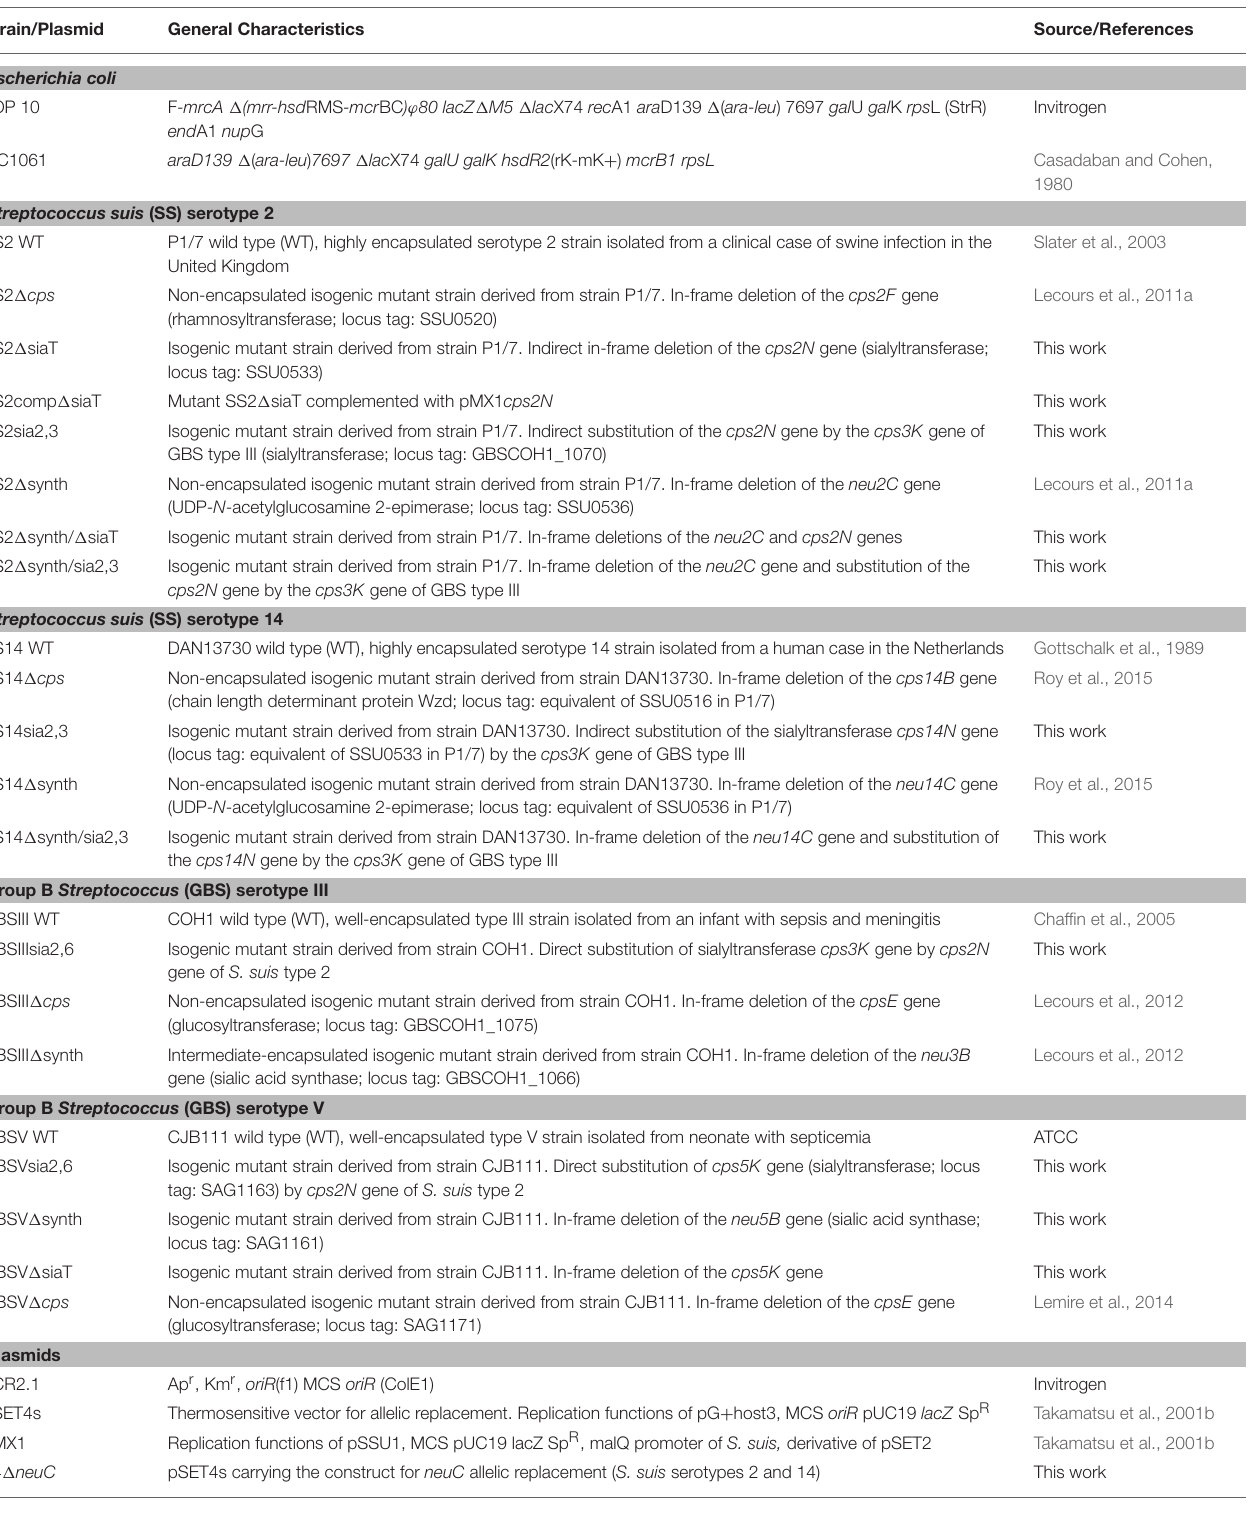
TABLE 1 | Bacterial strains and plasmids used in this